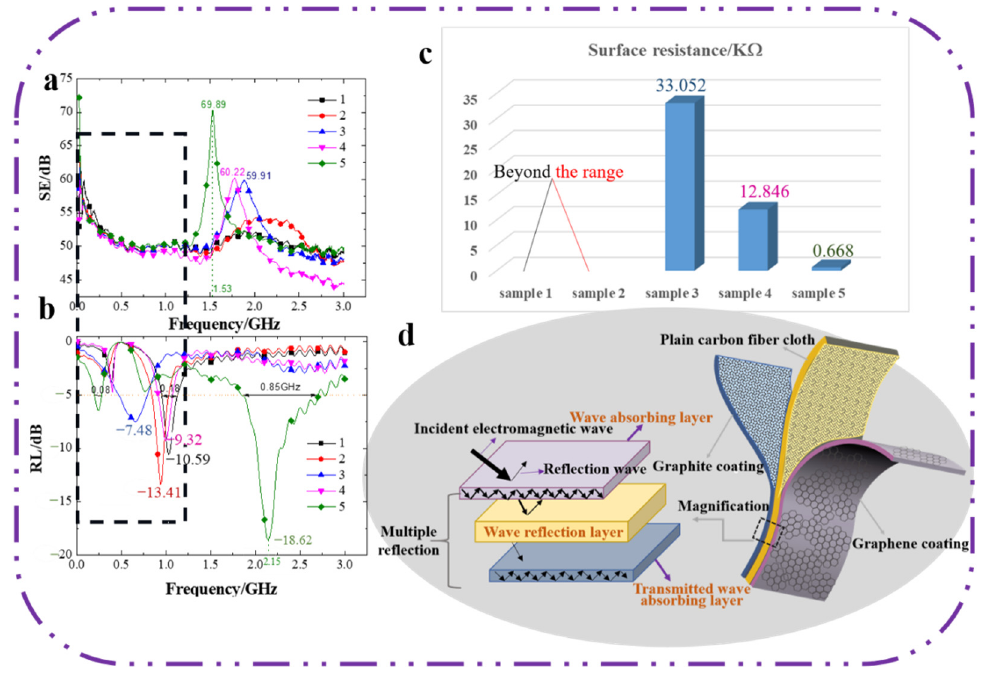
Figure 2. ( a ) The shielding properties of the composites. ( b ) The absorbing properties of the composites. ( c ) The conductive properties of the composites, ( d ) The structure model. Table 1. Table for technological parameters.